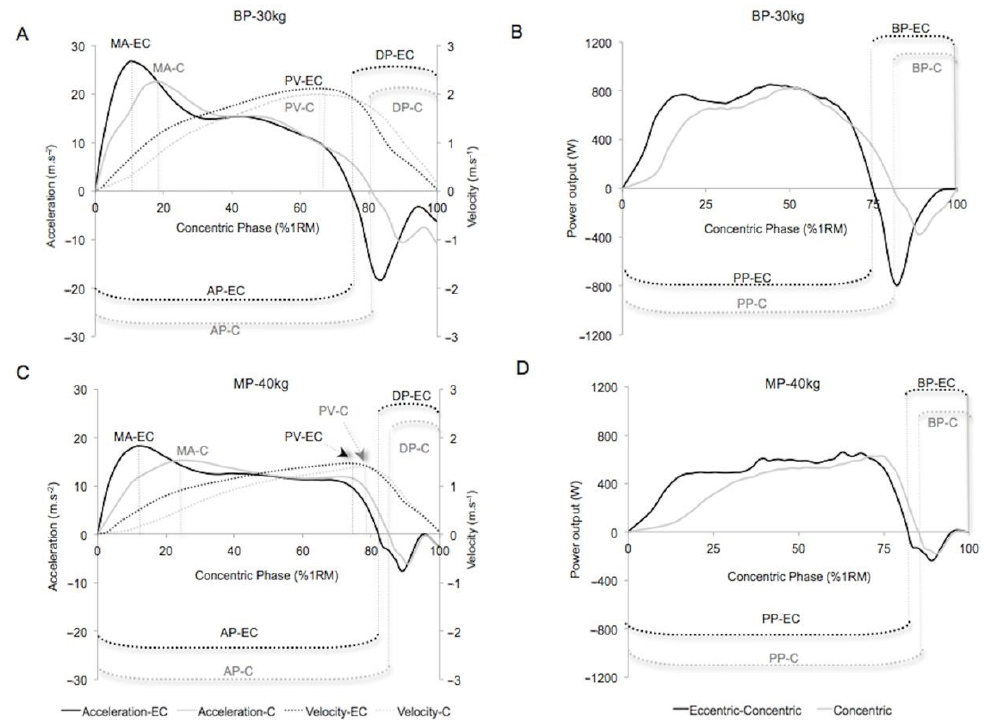
Figure 4. Example of differences between eccentric–concentric (EC) vs. concentric ( C ) phases when lifting the same light load for a representative subject. ( A ) Acceleration and velocity curves in bench press. ( B ) Power output curves in bench press. ( C ) Acceleration and velocity curves in military press. ( D ) Power output curves in military press. Abbreviations used in A,C: AP = acceleration phase; DP = deceleration phase; MA = peak acceleration; PV = peak velocity. Abbreviations used in B,D: BP = braking phase; PP = propulsive phase.